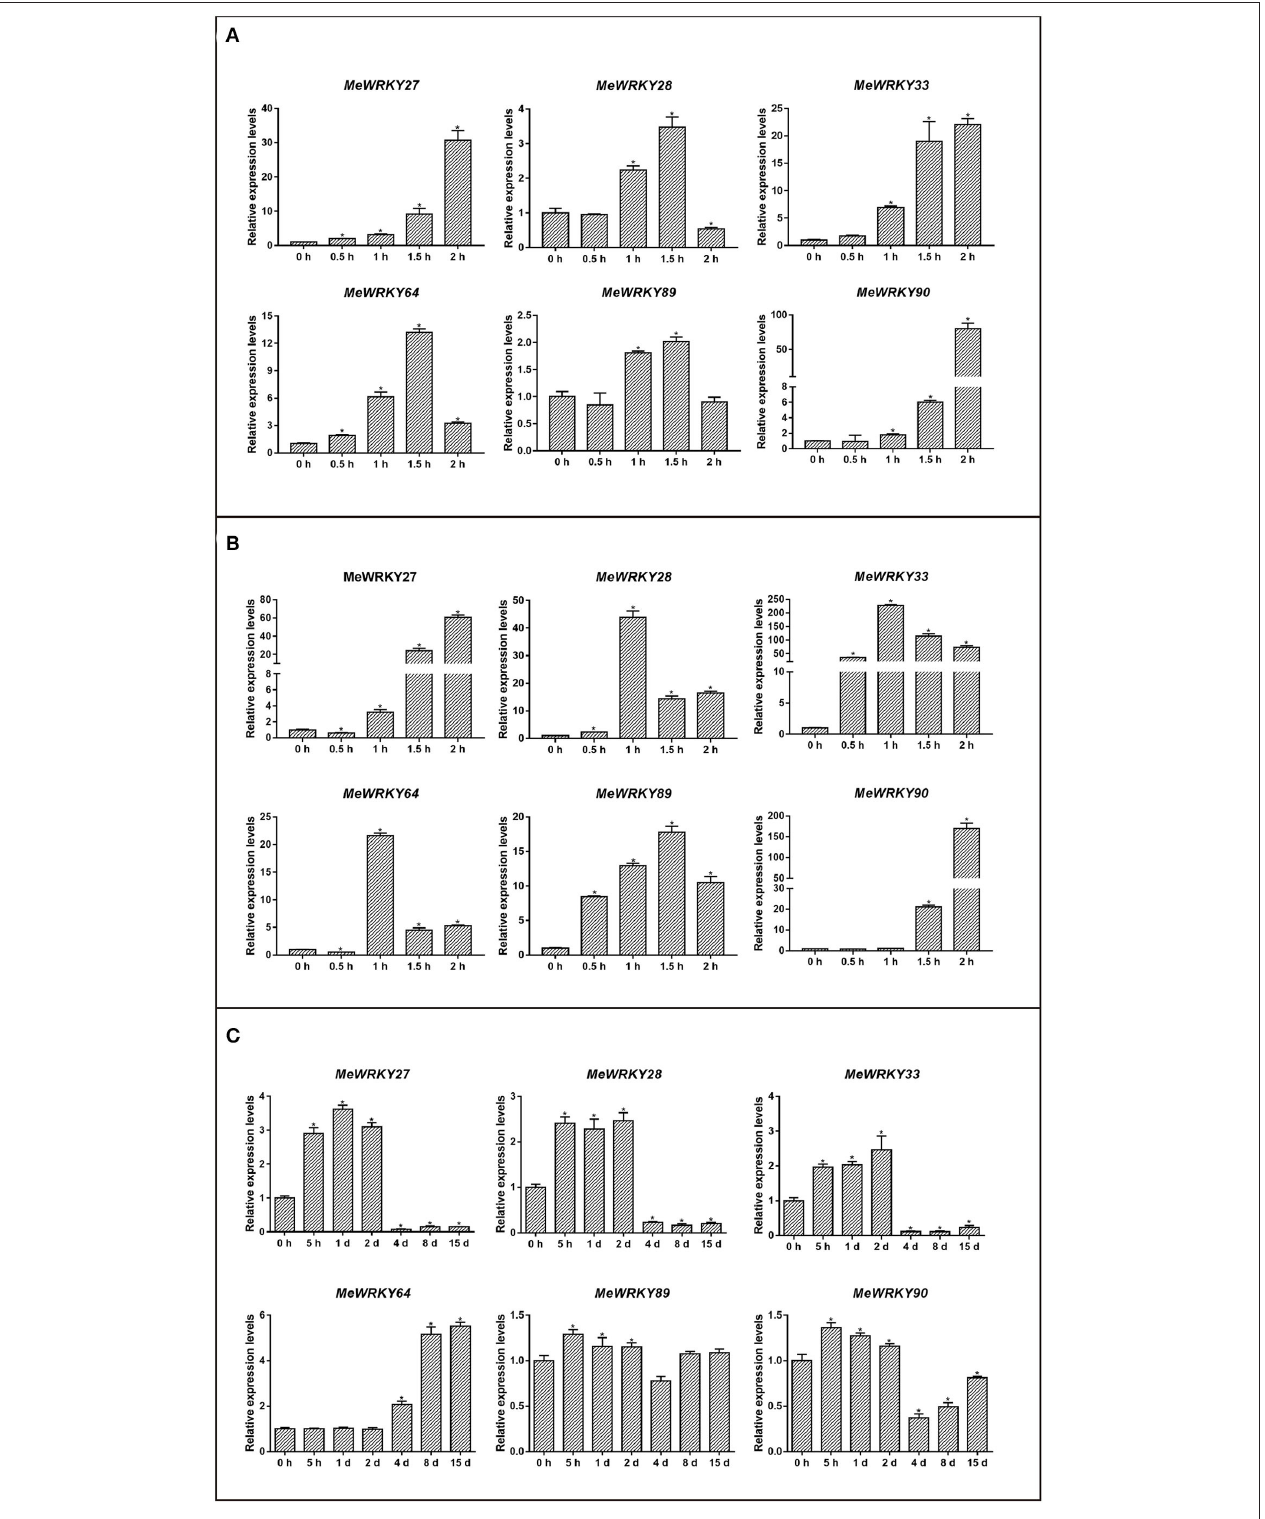
FIGURE 5 | Expression analysis of MeWRKY IIa genes in response to JA (A) , SA (B) , and Xam (C) . Each value represents the mean ± SD of three replicates. Asterisks indicate a significant difference ( p < 0.05) between control and treatments.